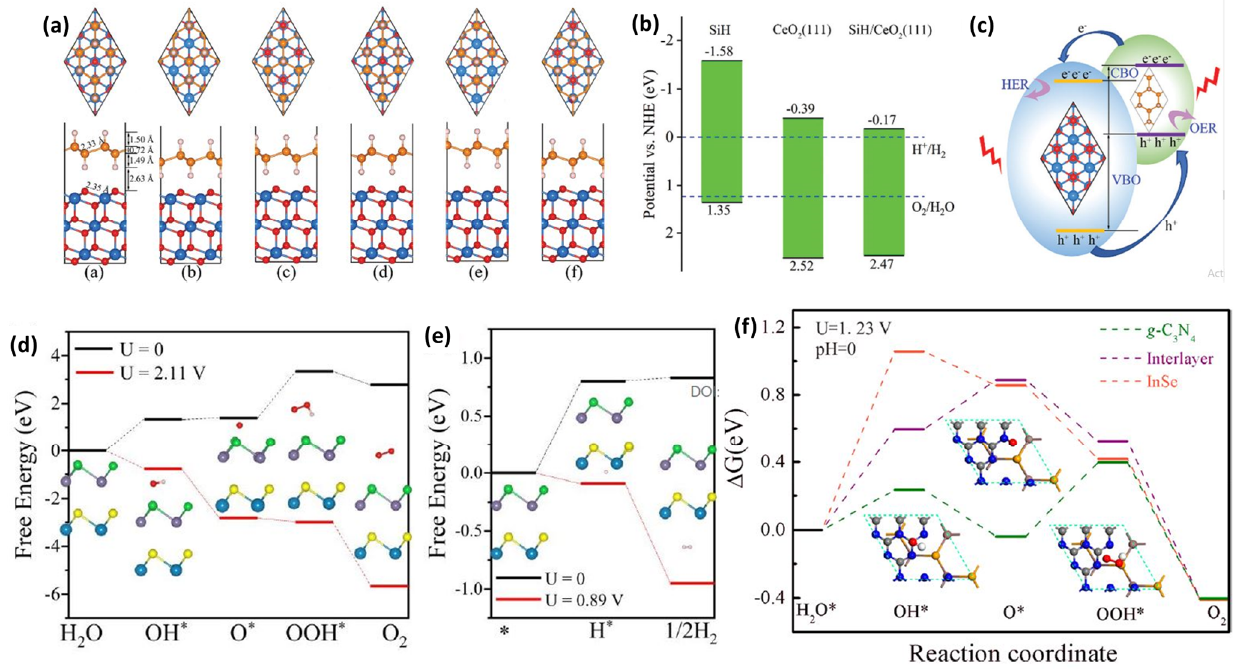
Figure 10. ( a ) The six different stacking patterns for 2 × 2 SiH/CeO 2 (111) heterojunctions, including top and side views. ( b ) Calculated band edge potentials versus NHE of SiH, CeO 2 (111), and SiH/CeO 2 (111) heterojunction. ( c ) Schematic diagram of charge transfer between SiH/CeO 2 (111) heterojunction layers. Reprinted with permission from ref. [216]. Copyright 2021 RSC. The free energy steps for ( d ) OER and ( e ) HER in SeGe@SSn for potential U = 2.11 V and U = 0.89 V at pH = 7. Reprinted with permission from ref. [119]. Copyright 2019 RSC. ( f ) The ΔG profiles of the OER (pH 0, U = 1.23 V) on the InSe surface, the g-C 3 N 4 surface, and the interlayer of InSe/g-C 3 N 4 . Reprinted with permission from ref. [217]. Copyright 2019 ACS.